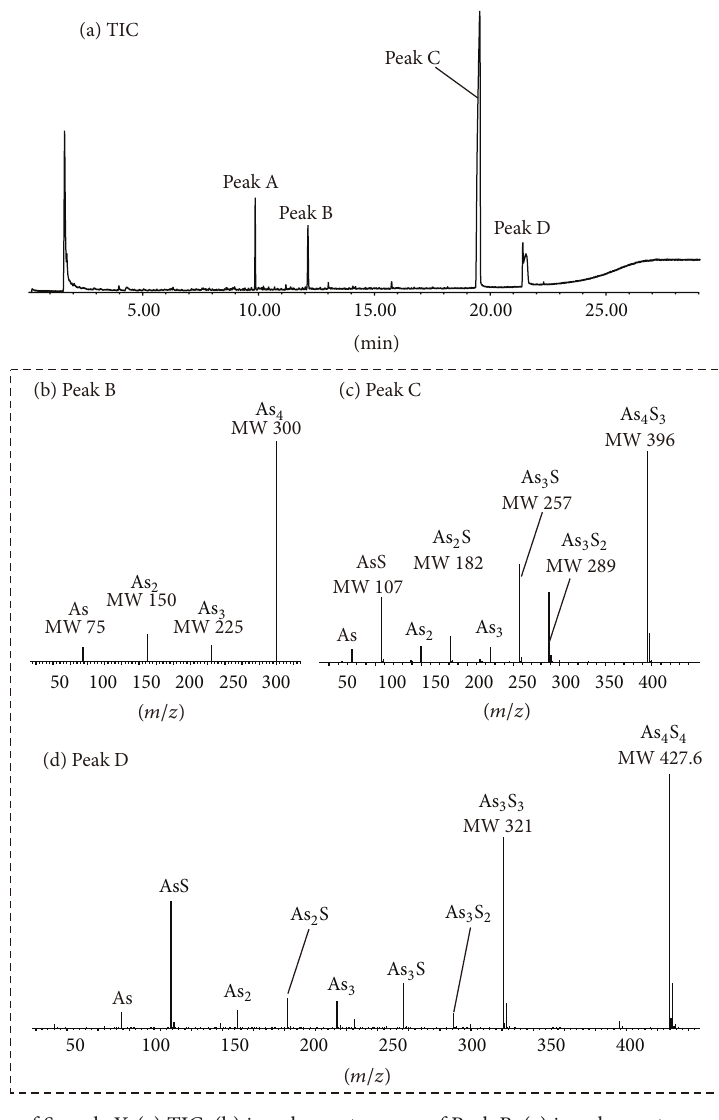
Figure 7: Py-GC/MS analyses of Sample Y. (a) TIC, (b) ion chromatograms of Peak B, (c) ion chromatograms of Peak C, and (d) ion chro- matograms of Peak